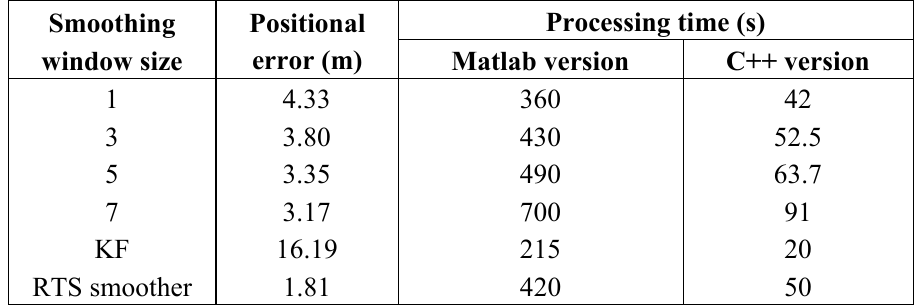
Smoothing rate/method Table 7. Relationship between smoothing window size and positional error and processing time. Positional Smoothing error (m) window size